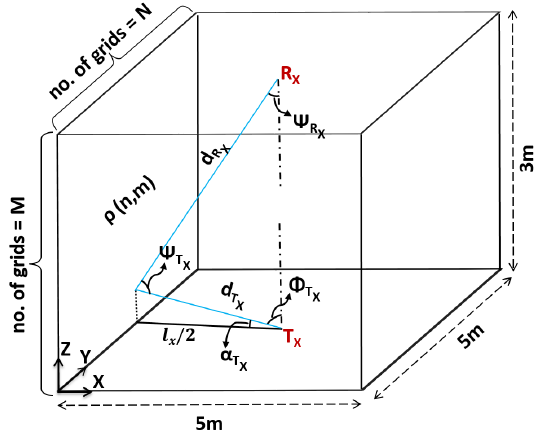
Figure 4. Analysis of the multiple reflected